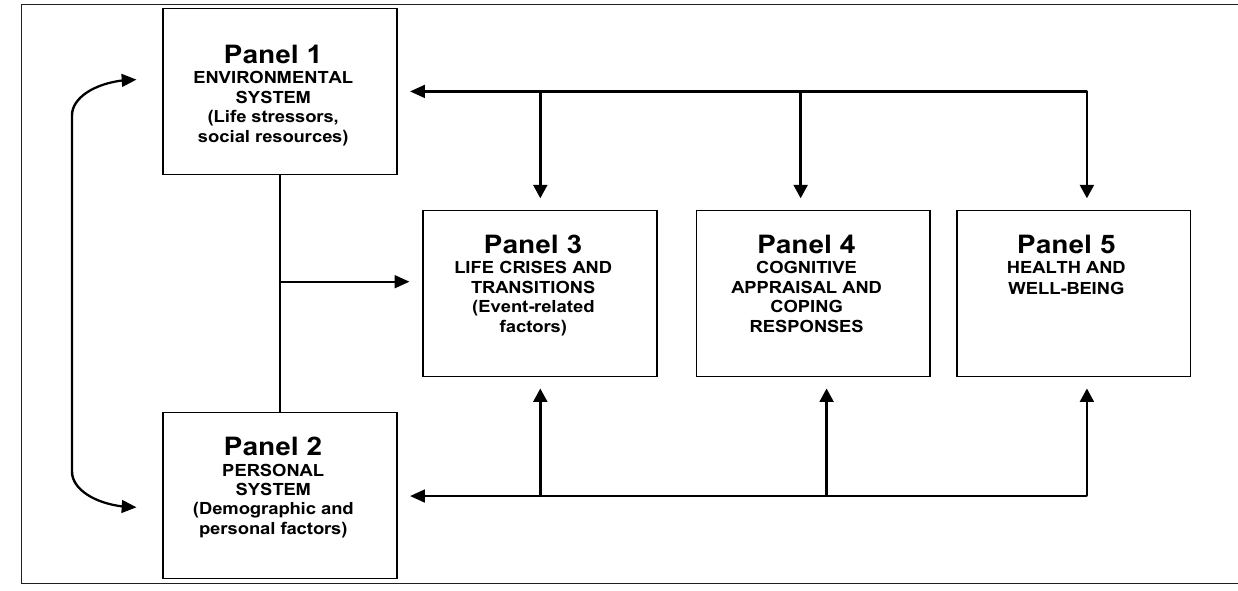
FIGURE 1 A general conceptual framework of the stress and coping